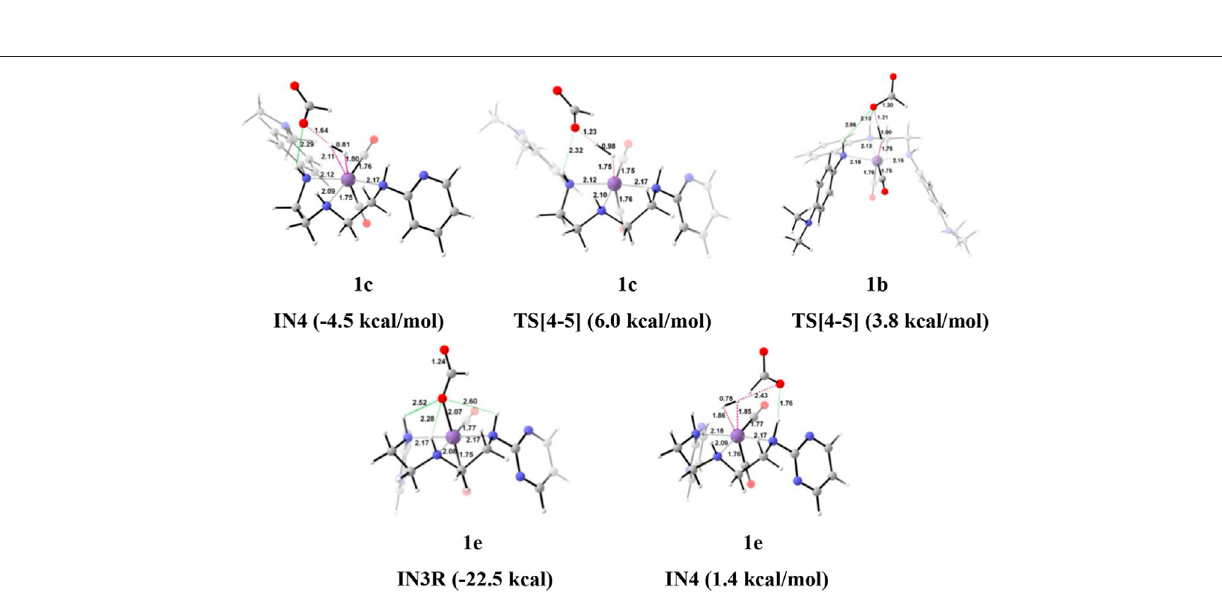
Frontiers in Chemistry |